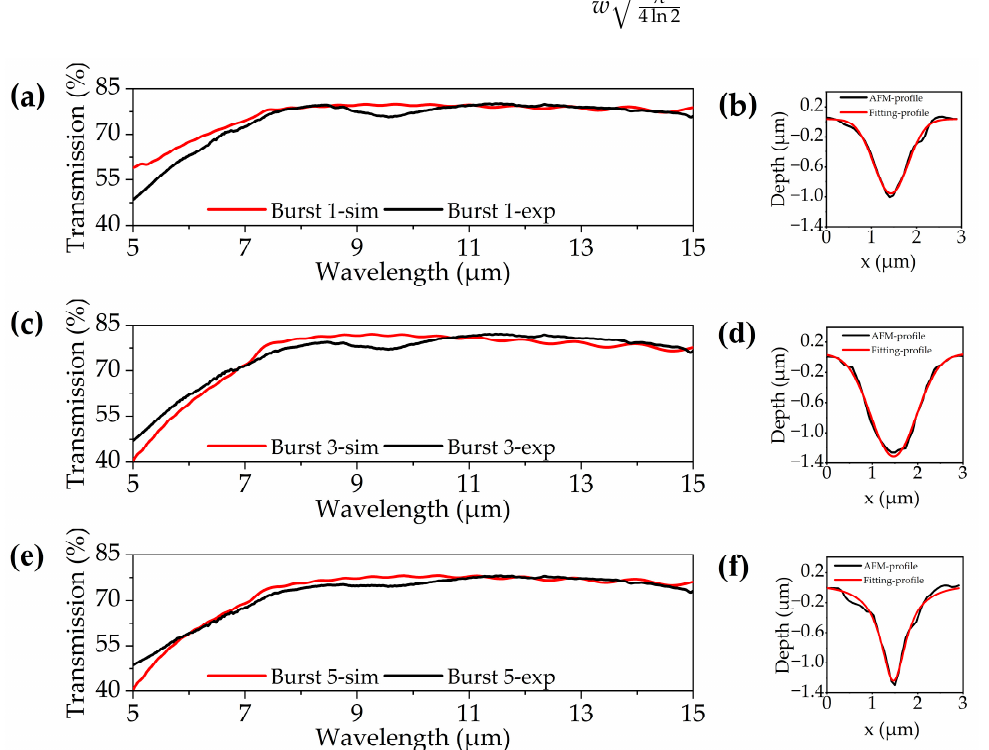
Figure 6. The simulation and experiment transmission of ARMs with 500 nJ of single-pulse energy in the range of 5–15 µm in ( a ) burst 1 mode, ( c ) burst 3 mode, and ( e ) burst 5 mode. The period of the ARMs was 3 µ m. The fitting and experiment profile of the ARMs in ( b ) burst 1 mode, ( d ) burst 3 mode, and ( f ) burst 5 mode.